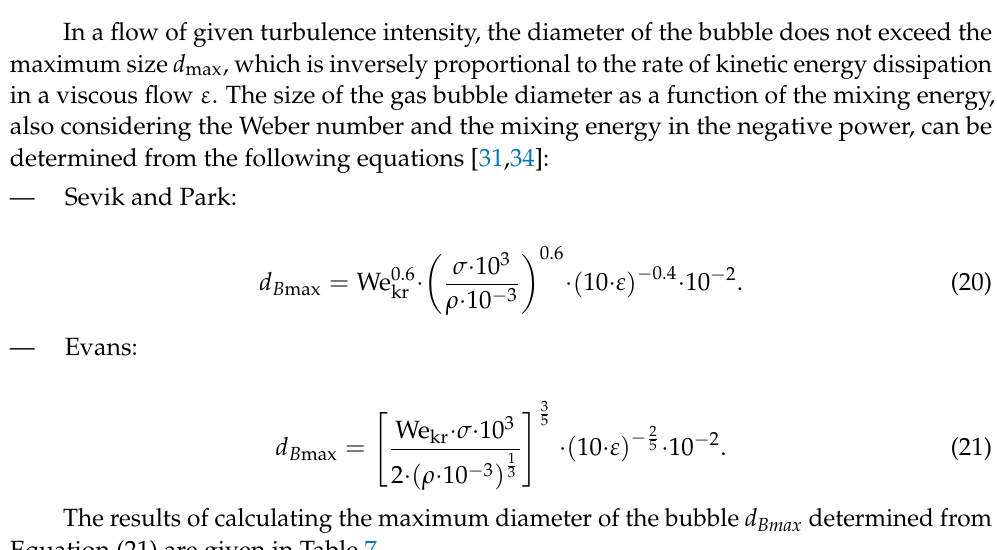
Figure 10. Effect of rotational speed on the bubble diameter.